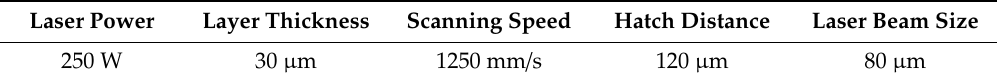
Figure 1. Scanning electron microscope image of the Nitinol powders used for the realization of the selective laser melting (SLM)-built samples. Table 1. Process parameters used for the manufacturing of the Nitinol samples.